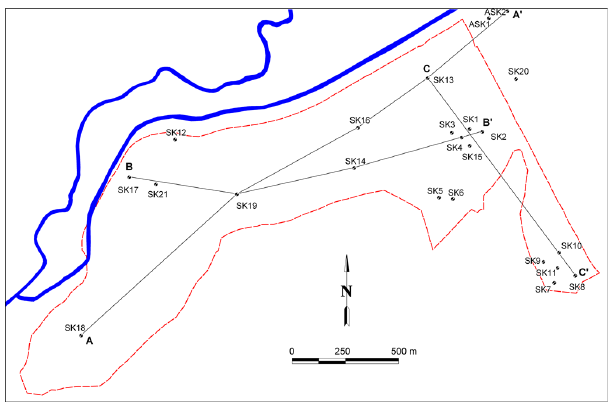
Fig. 6. Directions of cross-sections of the study